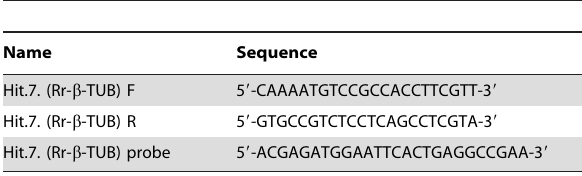
Table 2. R. reniformis b -tub primers for qPCR